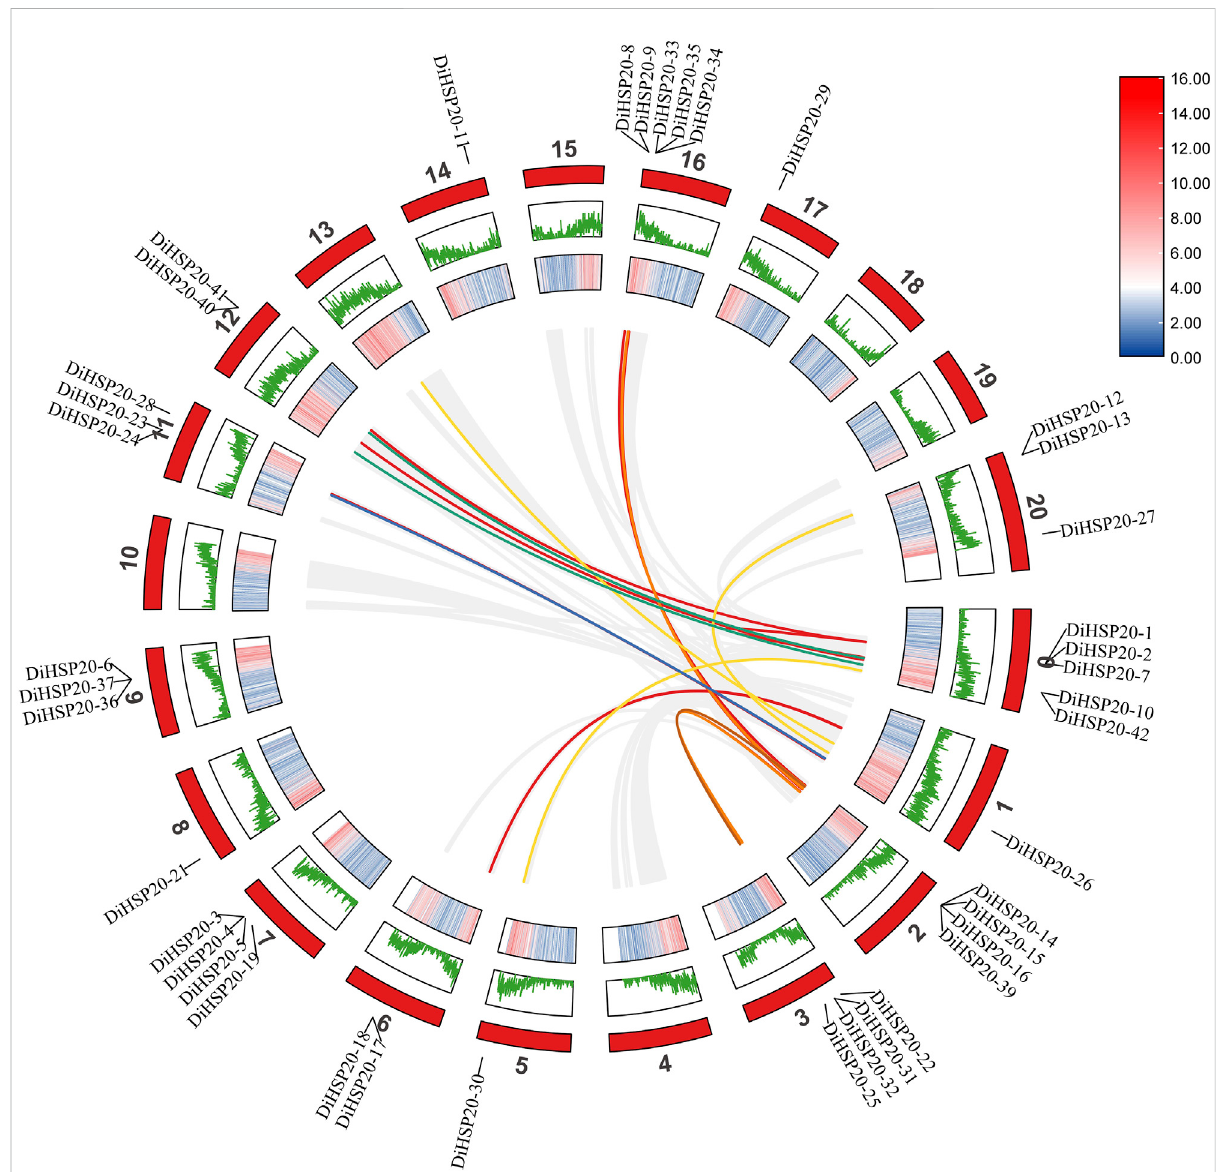
FIGURE 4 Synteny analysis between HSP20 genes of D. involucrata , as performed by MCScanX. The chromosome numbers of D. involucrata are 0 – 20. The outermost circle represents the length of the chromosome, the second circle represents the GC content and the third circle represents gene density. The curves indicate synteny between HSP20 genes within D.